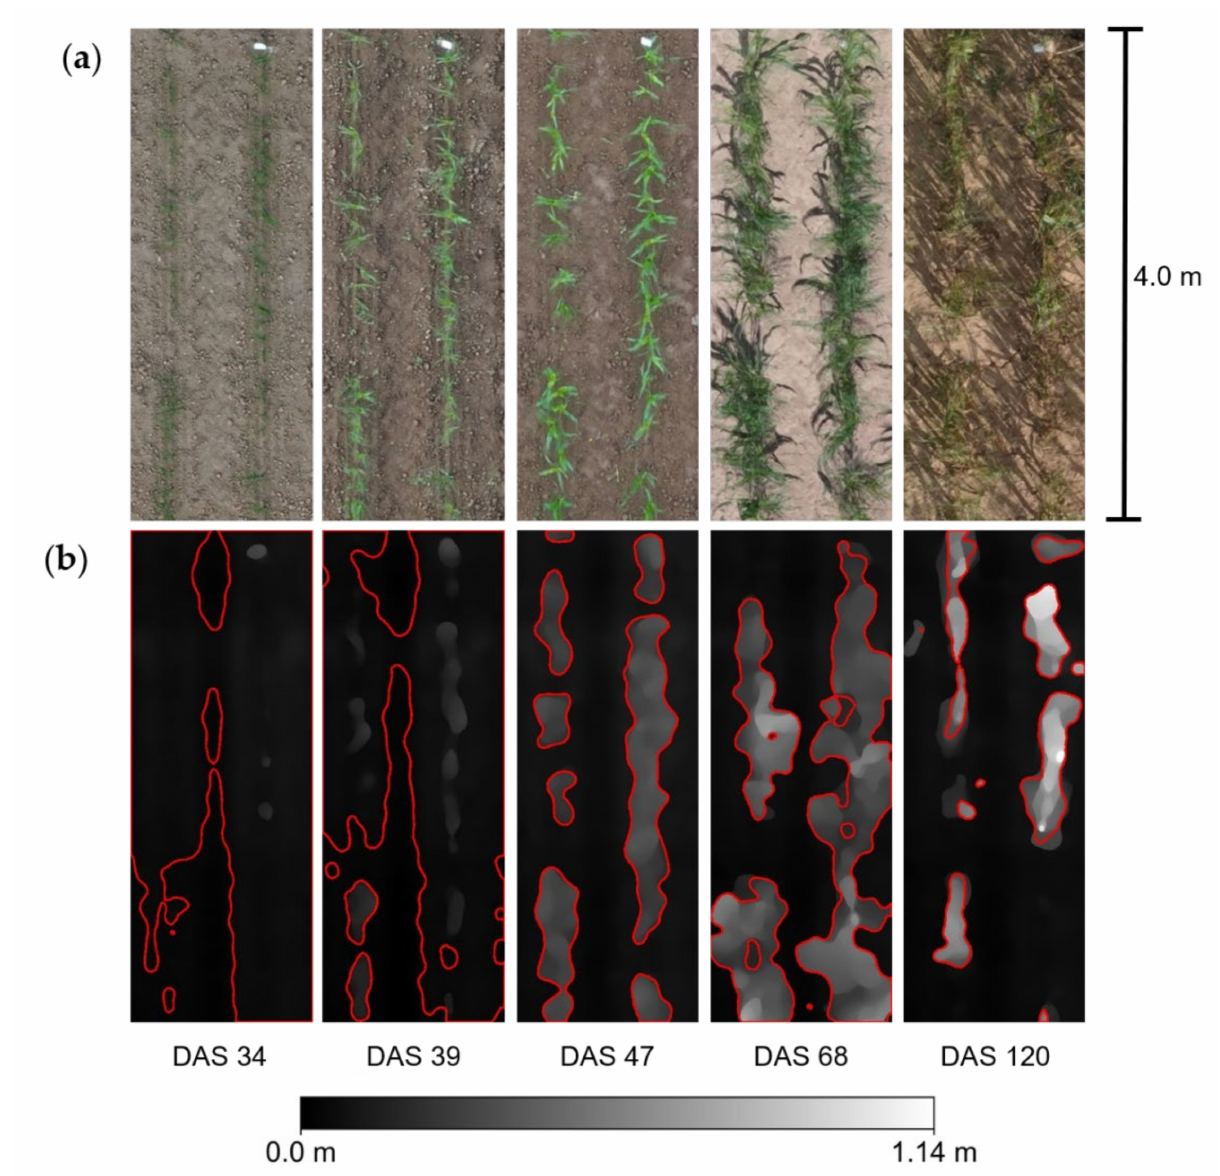
Figure 3. Maize plant development exemplified by one of the 400 genotypes surveyed by UAV at five stages during the growth period. ( a ) RGB image. The scale indicates the plot length; ( b ) heatmap of the digital surface model (DSM) for height estimation. The red contours indicate areas that were classified as plant and the grey scale bar shows plant height in meters; DAS: days after